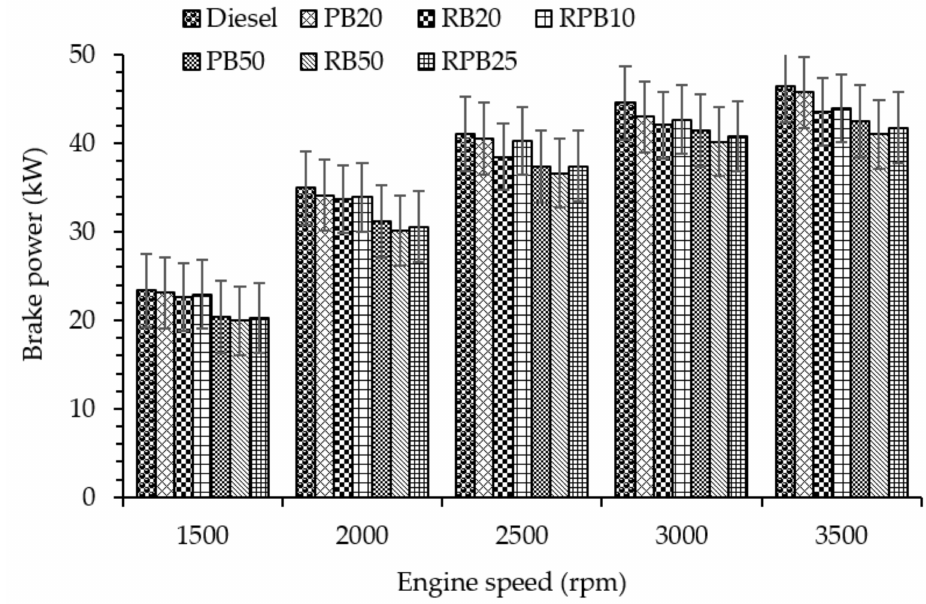
Figure 2. Variation of the BP with respect to engine